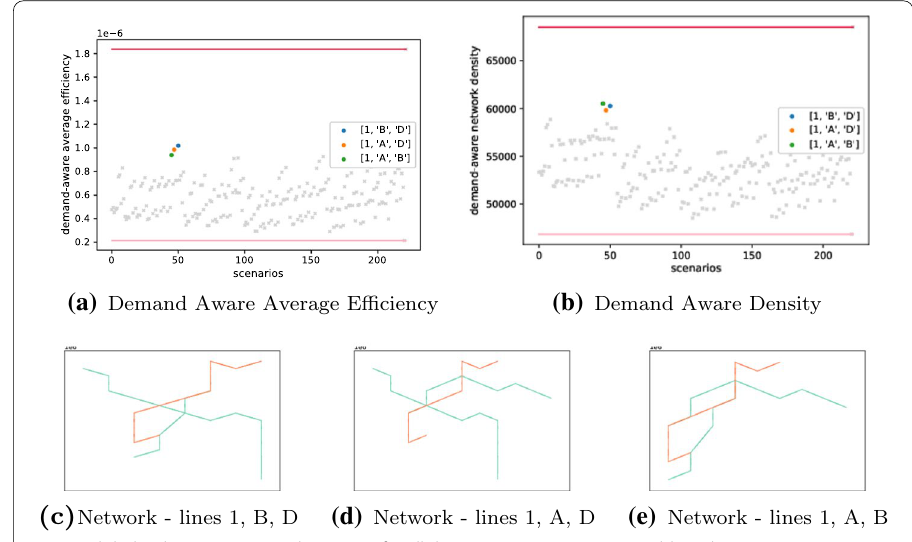
Fig. 8 Global indicators DAAE and (cid:31) DANDC (cid:30) for all the scenarios consisting in adding three new transport mode